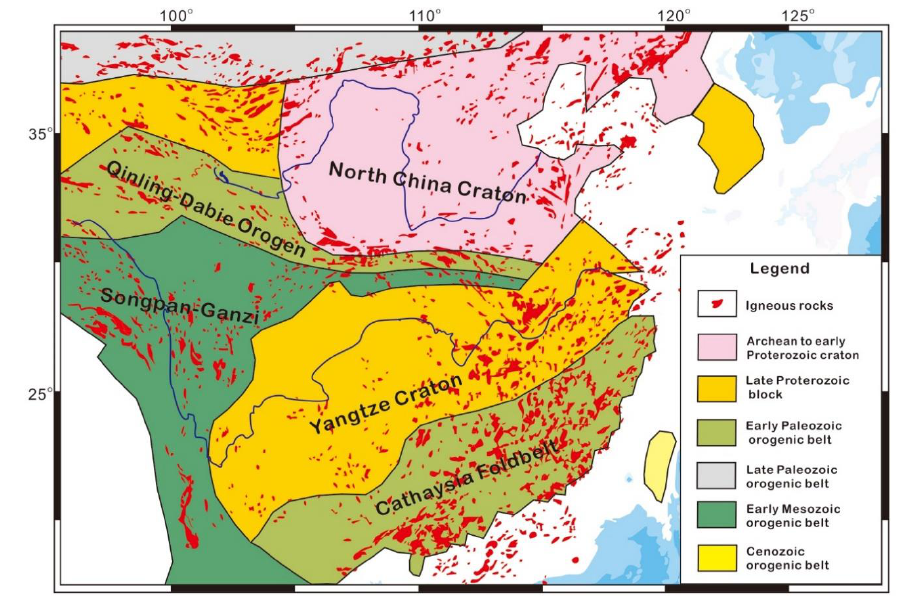
Figure 2. Schematic map illustrating ancient orogenic belts, first-order tectonic units and the distribution of igneous rocks in East Asia (modified after [41,42]).